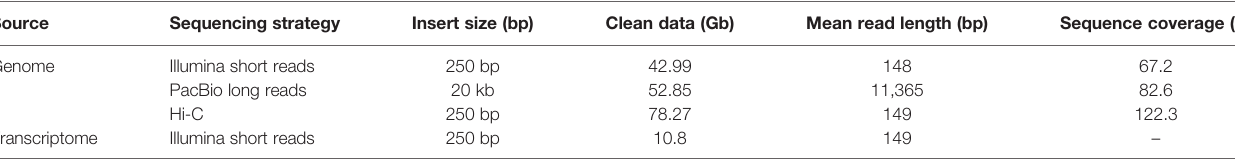
TABLE 1 | The statistics of the DNA and RNA sequencing data for the genome assembly and annotation.